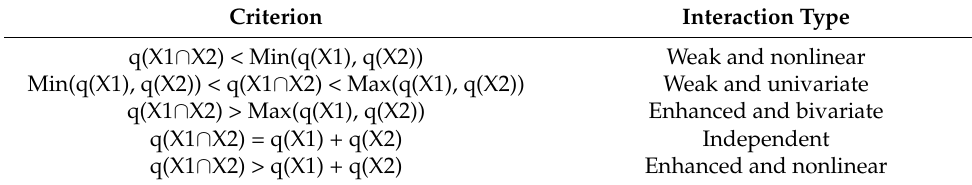
Table 5. Interaction types between two